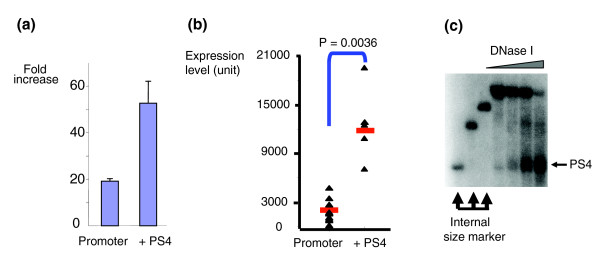
Functional assays indicate enhancer activity for a representative primate-conserved element, human LDLR PS4. Luciferase assay analysis of (a) transient transfections into human HepG2 cells and (b) plasmid DNA transfer into mouse liver. The luciferase reporter constructs tested are either the LDLR promoter alone (promoter), or the promoter in combination with the human LDLR PS4 (+ PS4). Fold increase over the empty vector is shown. Error bars in (a) indicate standard deviation. Each triangle in (b) represents luciferase activity in an individual mouse. Red bars denote the median activity of each construct. Luciferase activity is reported in arbitrary units. (c) DNase I hypersensitive site mapping around the LDLR PS4 region in human liver cell line HepG2. Vertical arrows indicates the lane with internal size marker that was generated by enzyme digestion of the LDLR PS4 sequence. The hypersensitive site is indicated by a horizontal arrow. Co-migration of the internal size marker with the hypersensitive site localizes the hypersensitive site to the LDLR PS4 sequence.